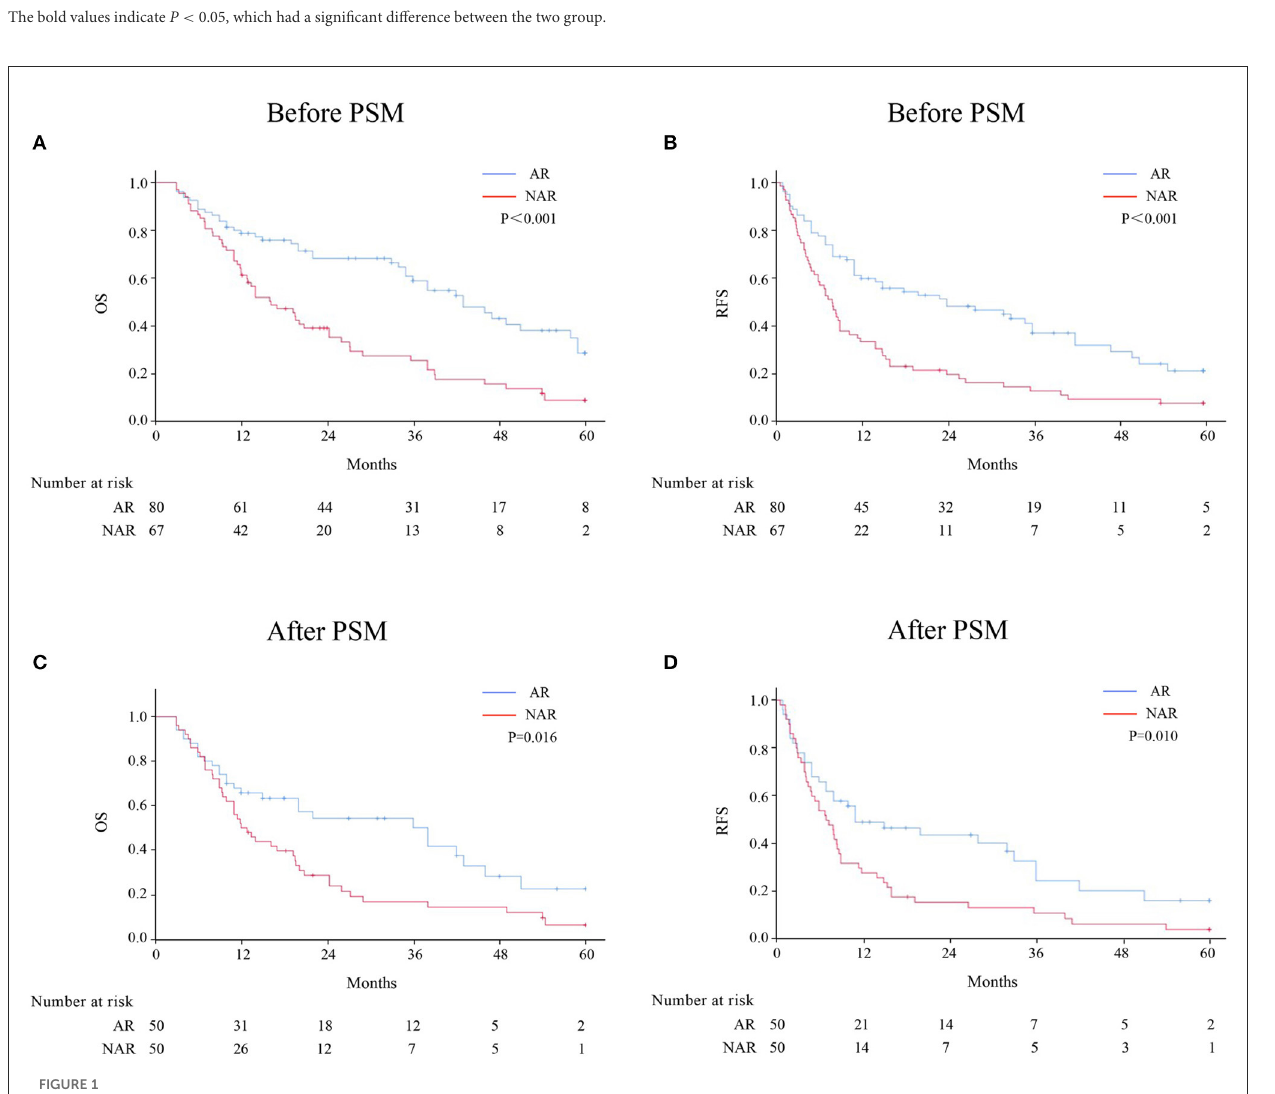
with a low rate of recurrence (23, 24). Thus, patients with HICC may benefit from